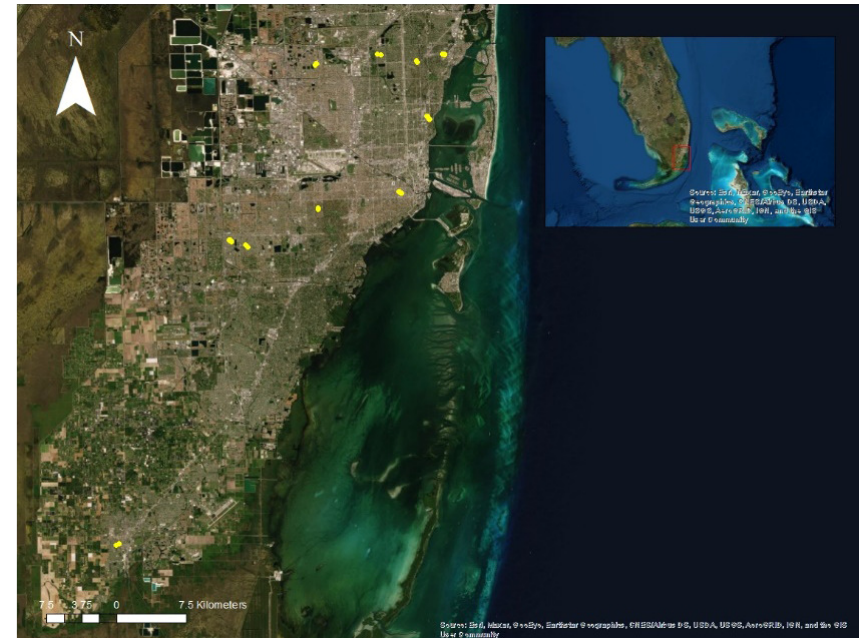
Figure 1. Miami‐Dade County, Florida. Yellow dots indicate sites (10) where FF and UF plots were